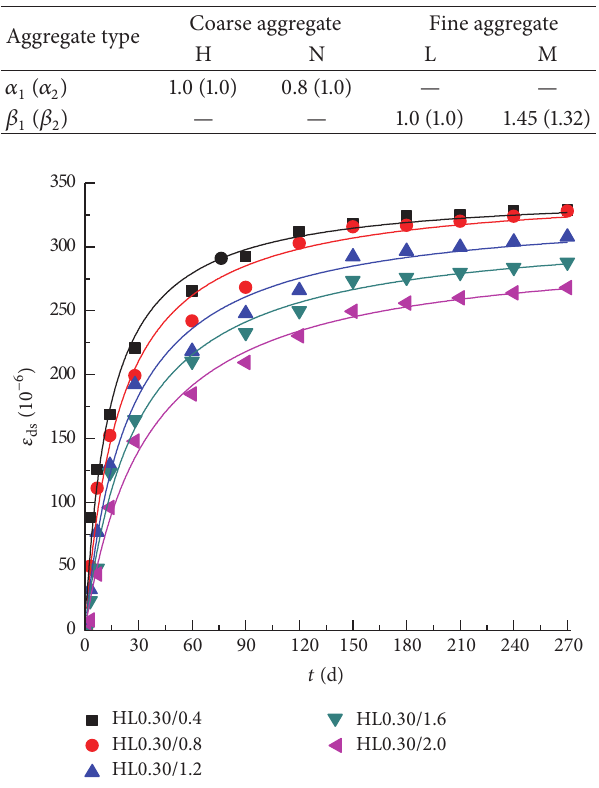
Table 8: Values of influencing factors in formula (1).